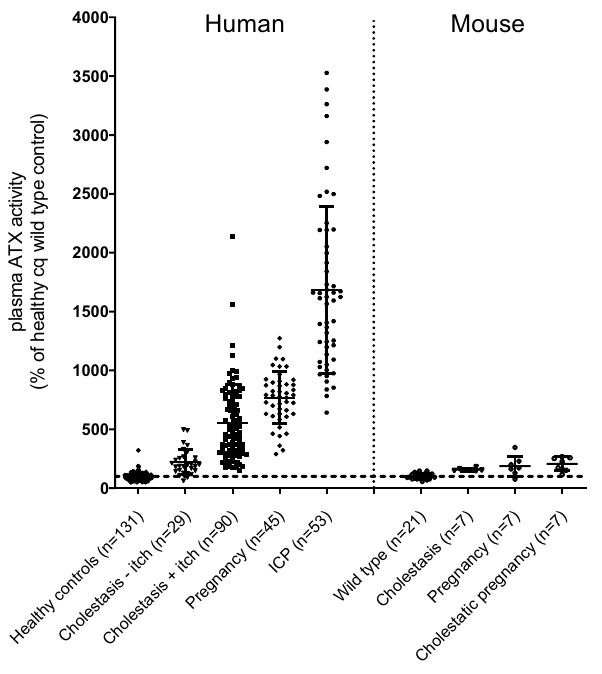
Figure 4. Plasma ATX activity relative to healthy control in man (left part of the figure) or wild type control and cholestatic Atp8b1 mutant mice (right part of the figure); human data adapted from 10,14 , mouse data adapted from Fig.